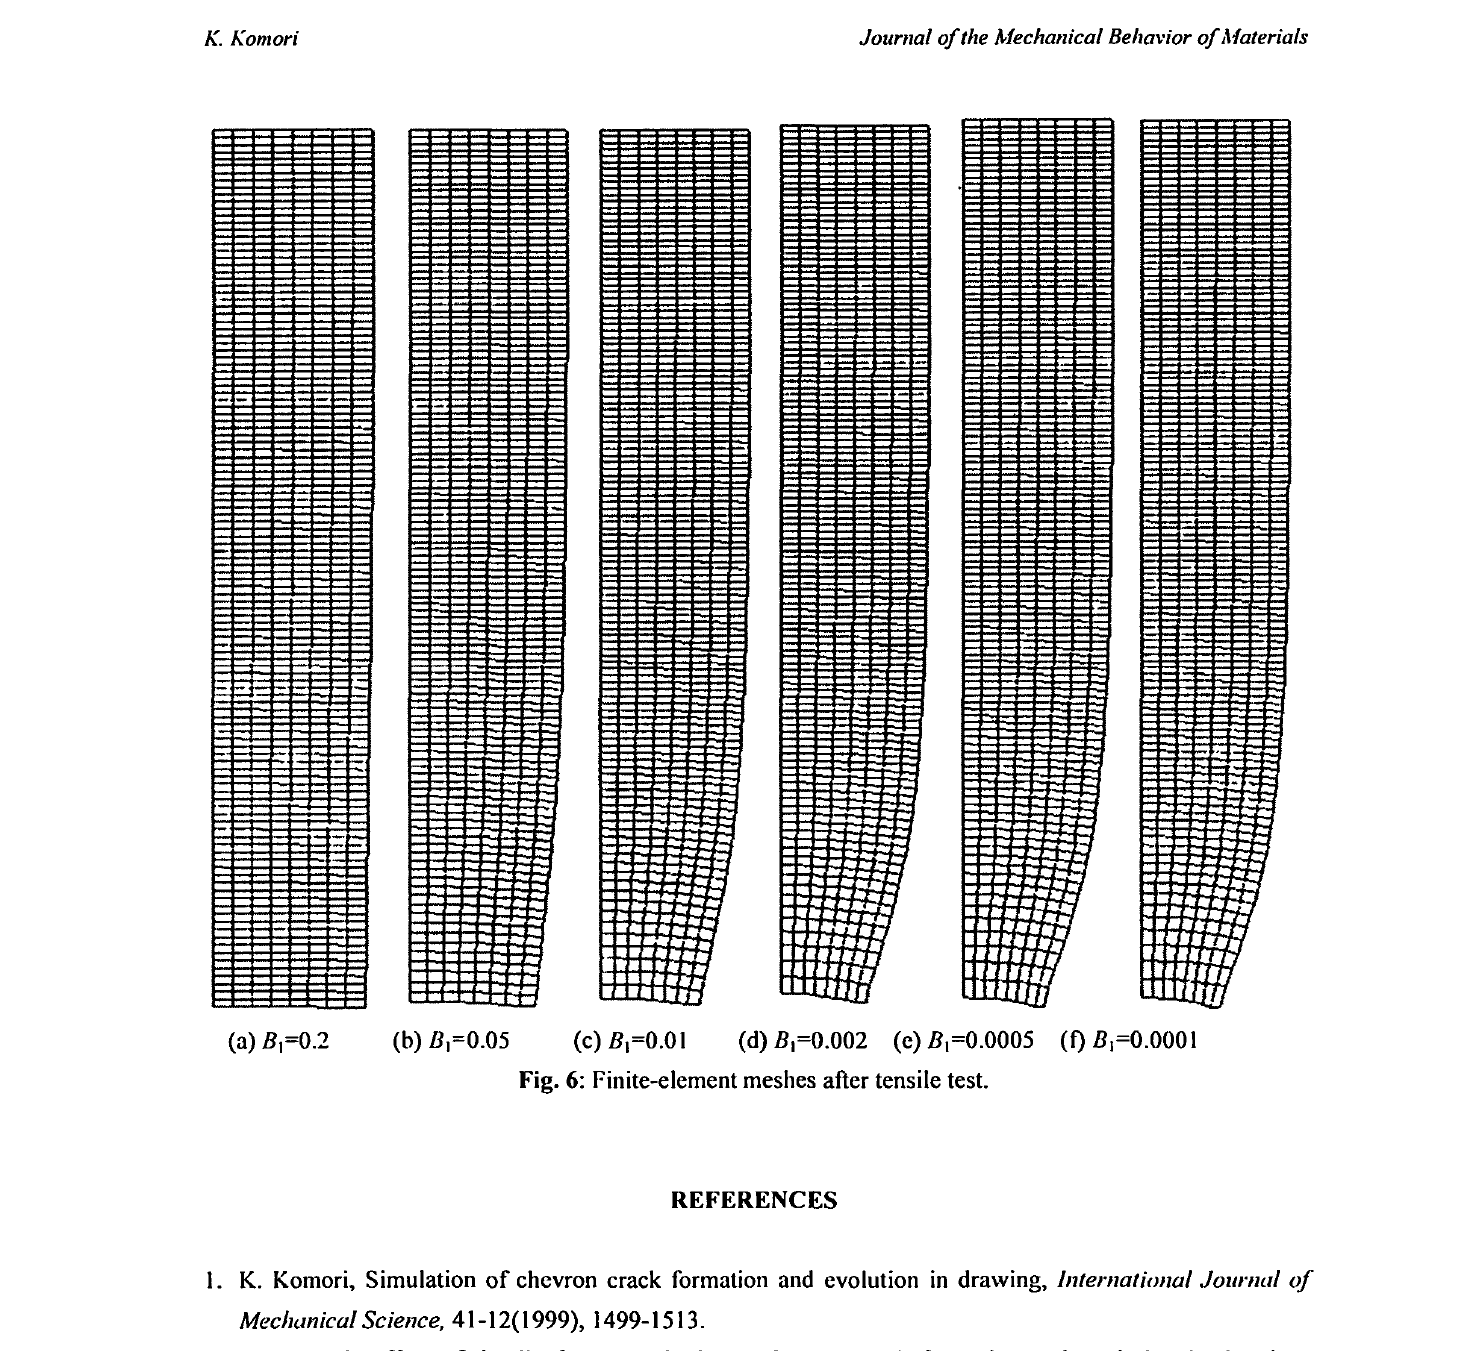
Fig. 6: Finite-element meshes after tensile